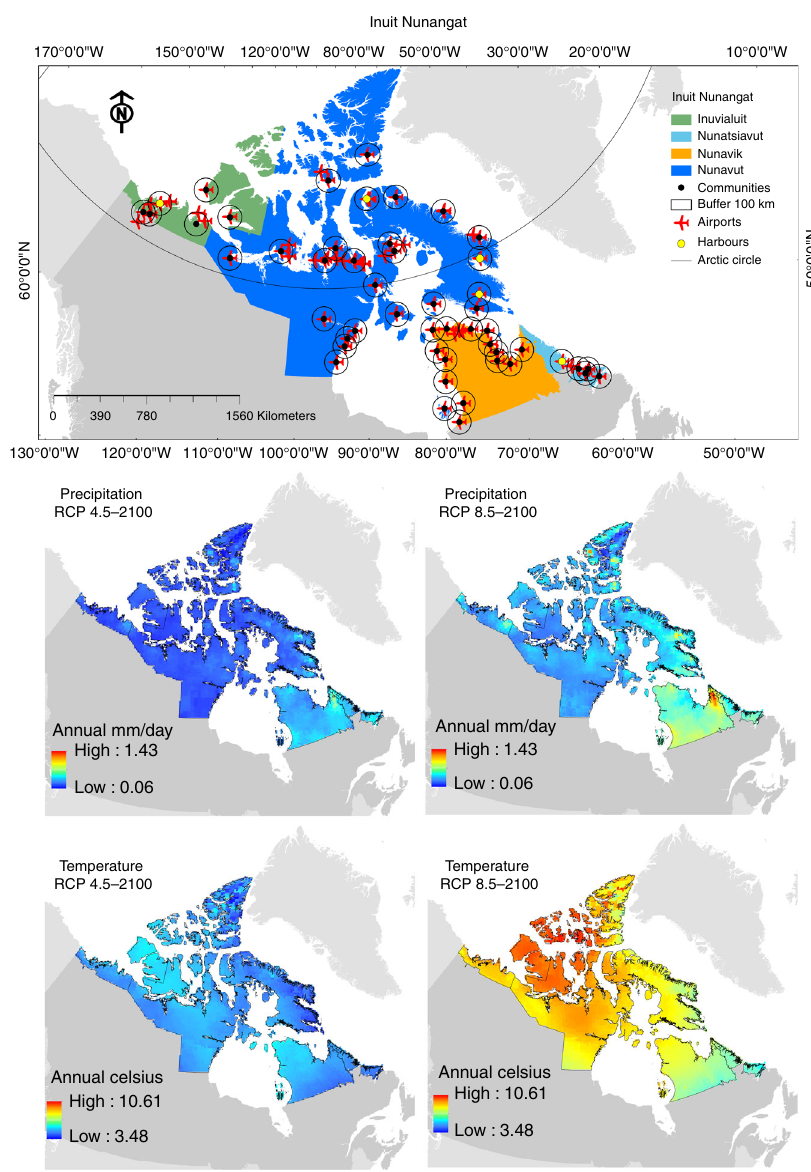
Fig. 2 The top map shows the Inuit Nunangat region — which includes four divisions (Inuvialuit, Nunavut, Nunavik and Nunatsiavut) — and 50 inhabited communities (black dots). Buffer areas of 100-km represent areas analyzed in each community; red airplanes are airports and yellow dots harbors. The four bottom maps illustrate climate models increase values (delta) for annual mean precipitation (mm/day) and annual mean temperature (°C) for both RCP4.5 and 8.5 scenarios at the end of the century